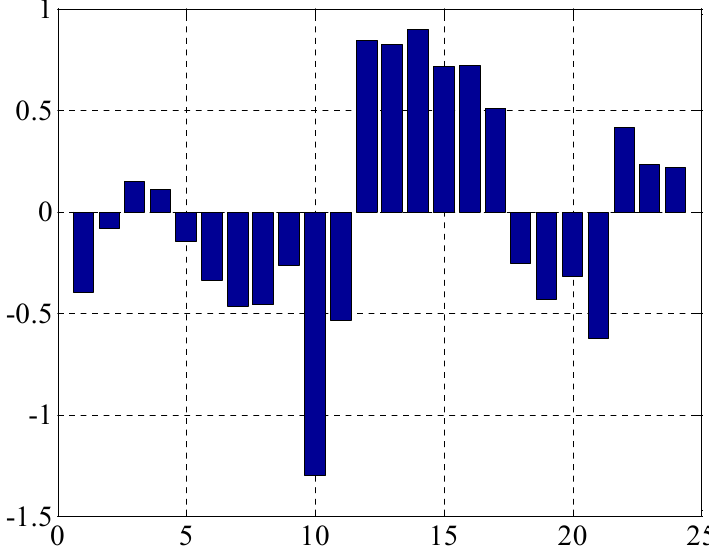
Figure 27. The performance index